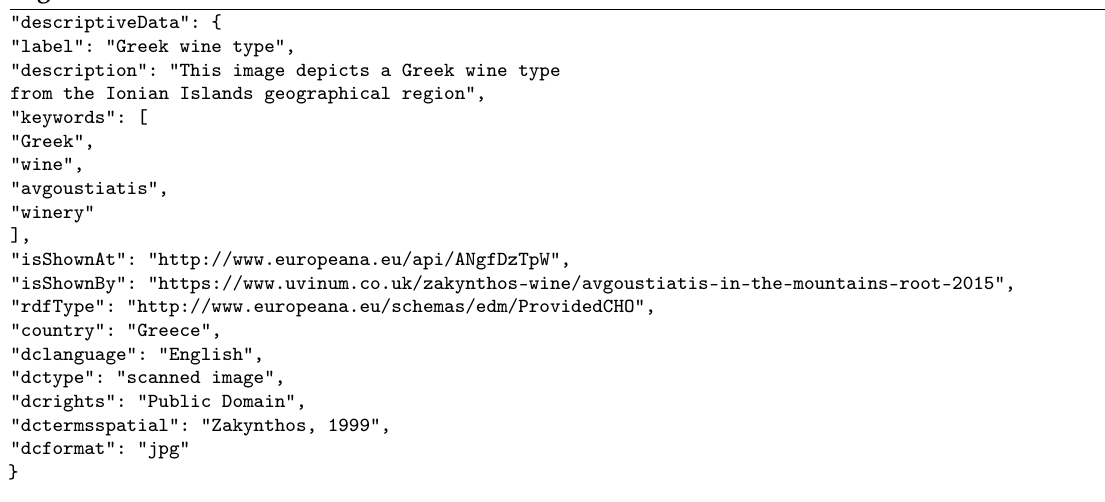
Algorithm 1 Platform’s